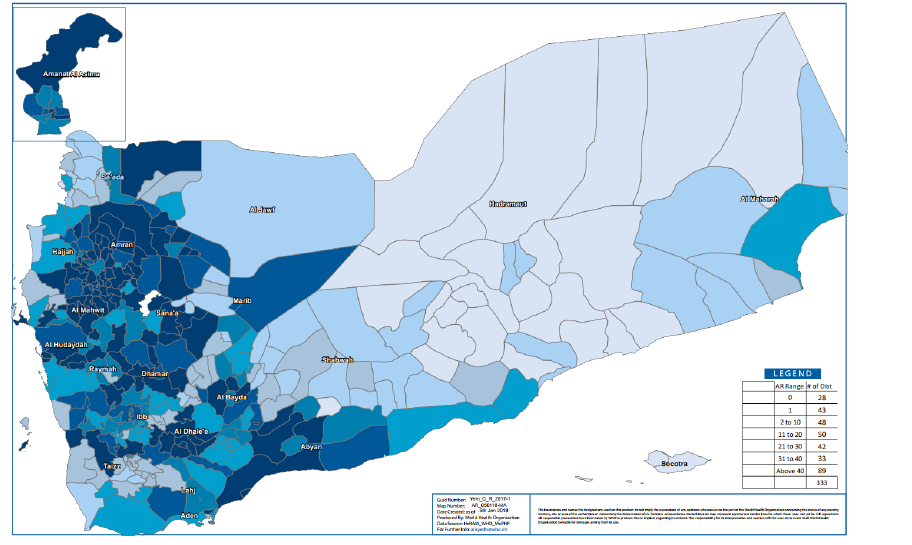
Figure 1. WHO’s 2018 Map of Attack Rates in Different Regions of Yemen. Data source: HeRAM_WHO_MoPHP.